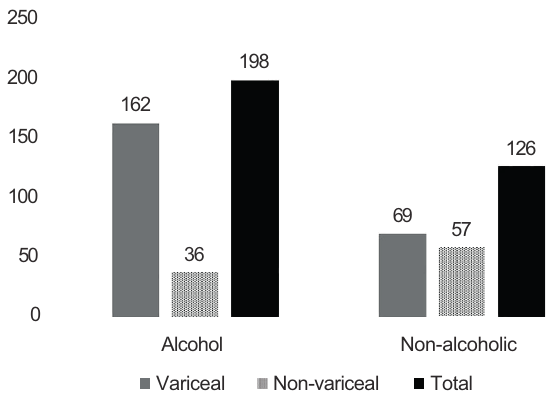
Figure 2: Spectrum of upper GI bleed in alcoholics (n = 198) and nonalcoholics (n =